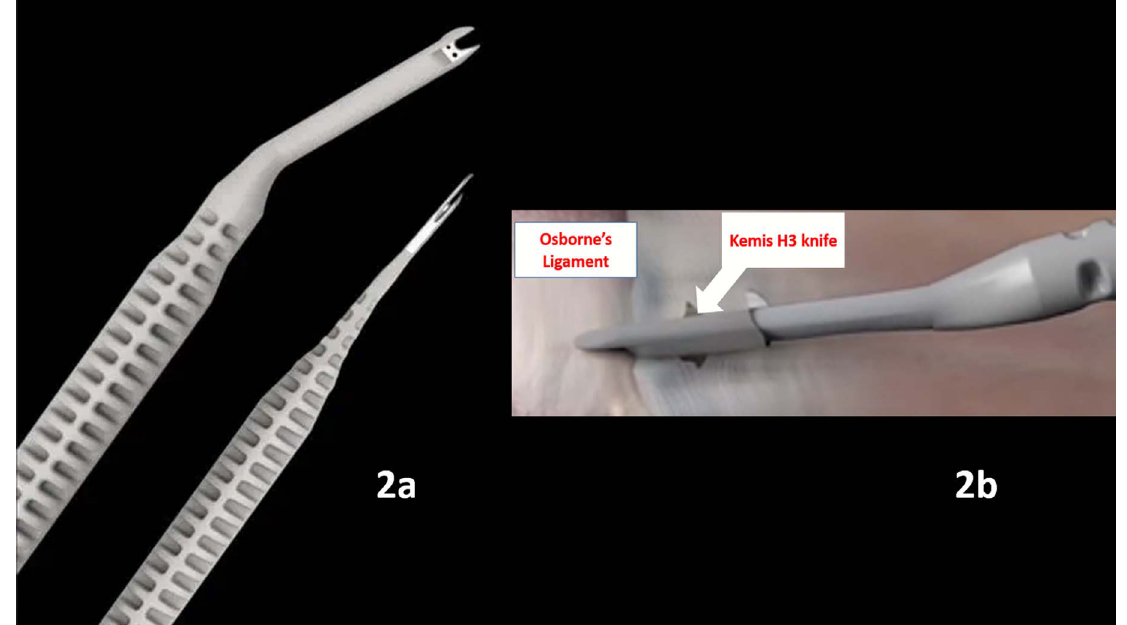
Figure 2. (a) Example of Kemis knives: on the left, the Kemis H3 blade used in the present study. On the right, the Kemis H1 blade can be used for treatment of trigger fi ngers or De Quervain tenosynovitis. (b) Illustration of the Kemis knife as used to transect Osborne ’ s